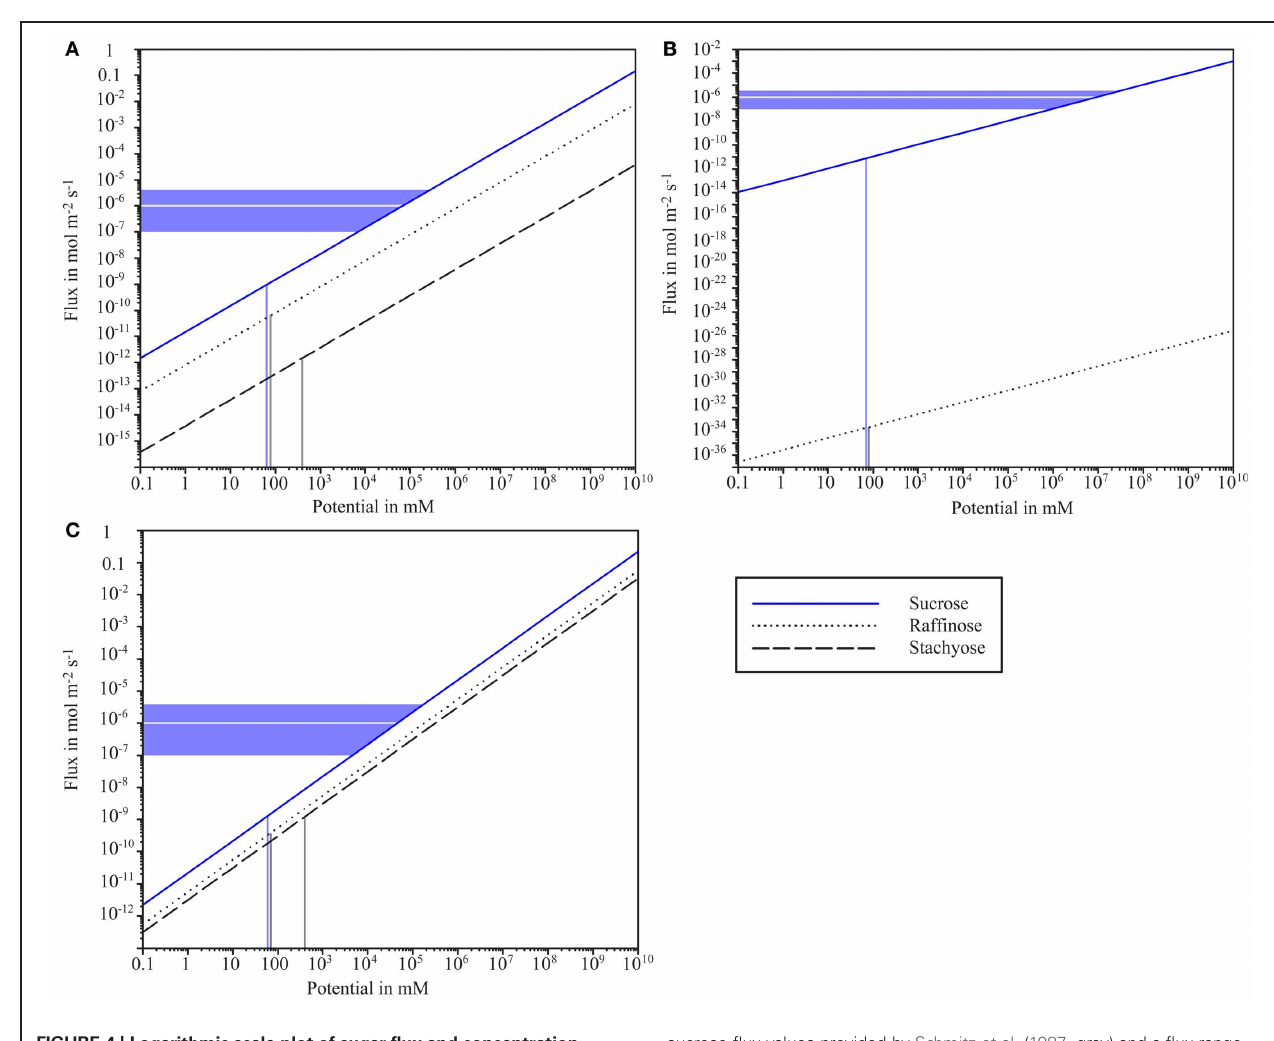
FIGURE 4 | Logarithmic scale plot of sugar flux and concentration potential between bundle sheath cells and intermediary cells for different plasmodesmata configurations. (A) Sub-nano channel configuration assuming 9 channels with 6.5Å radius. (B) Slit configuration assuming half slit width of 5.2Å. (C) Hydrogel configuration assuming a polymer volume fraction of 0.49. Vertical lines indicate sugar concentration potentials as provided by Haritatos et al. (1996). Horizontal lines indicate